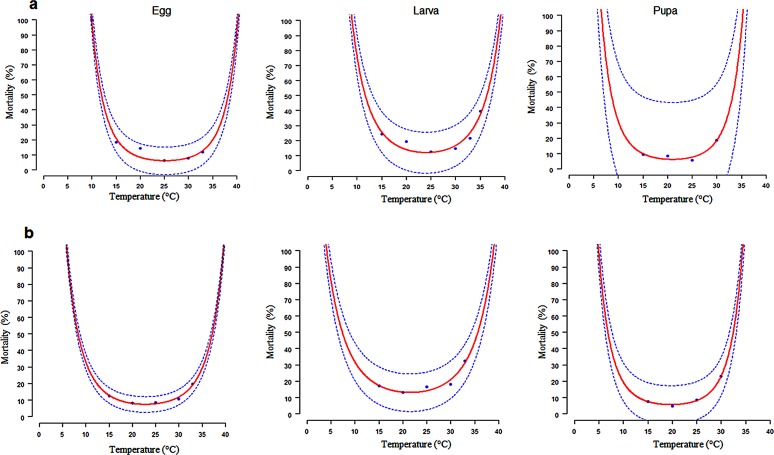
Temperature-dependent mortality rates of C. rosa (1a) and C. quilicii (1b) immature life stages (egg; larva and pupa) at six different constant temperatures. Fitted curves: Polynomial regression for all immature stages. The upper and lower 95% confidence intervals of the model are indicated. Markers are observed means, bars represent standard deviation.